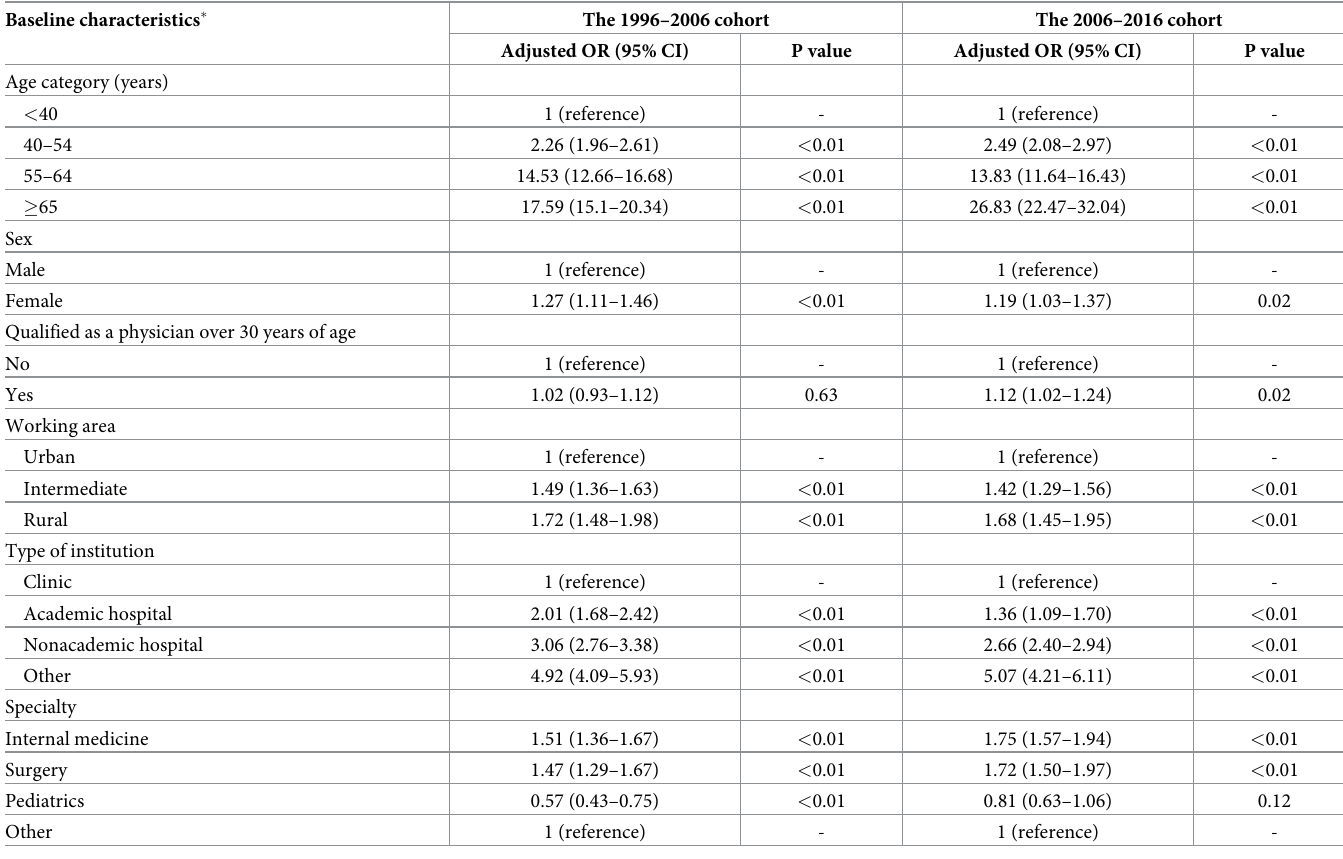
Table 3. Multivariable logistic regression analysis to identify physician factors associated with starting to work in GHSFs 10 years later. Baseline characteristics